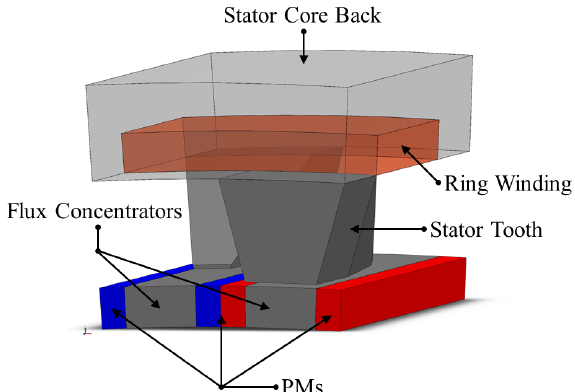
Figure 1: One pole pair of one phase of a claw pole TFPM motor.